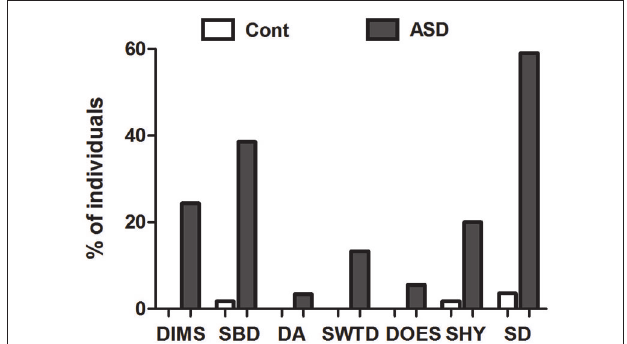
FIGURE 1 | Percentage of individuals experiencing sleep disturbances . Distribution in percentage (%) of subjects in the control group and the group with autism spectrum disorder (ASD) who had sleep disorders according to the Sleep Disturbance Scale for Children (SDSC), within the following sub-items: disorders of initiating and maintaining sleep—DIMS, sleep-breathing disorders—SBD, disorders of arousal—DA, sleep-wake transition disorders—SWTD, disorders of excessive somnolence—DES and sleep hyperhydrosis—SHY. N = 56 in the control group and 45 in the ASD group.